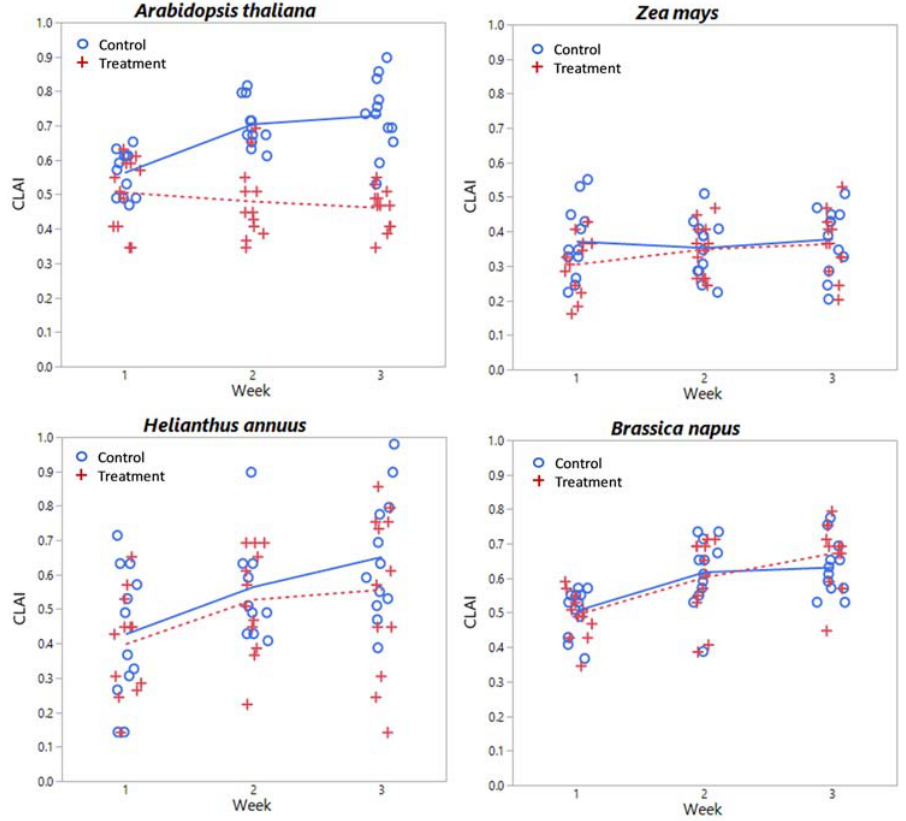
Figure 8 . CLAI by week and treatment level for each species considered. Lines (solid = control, dashed = treatment) indicate mean values at each week.